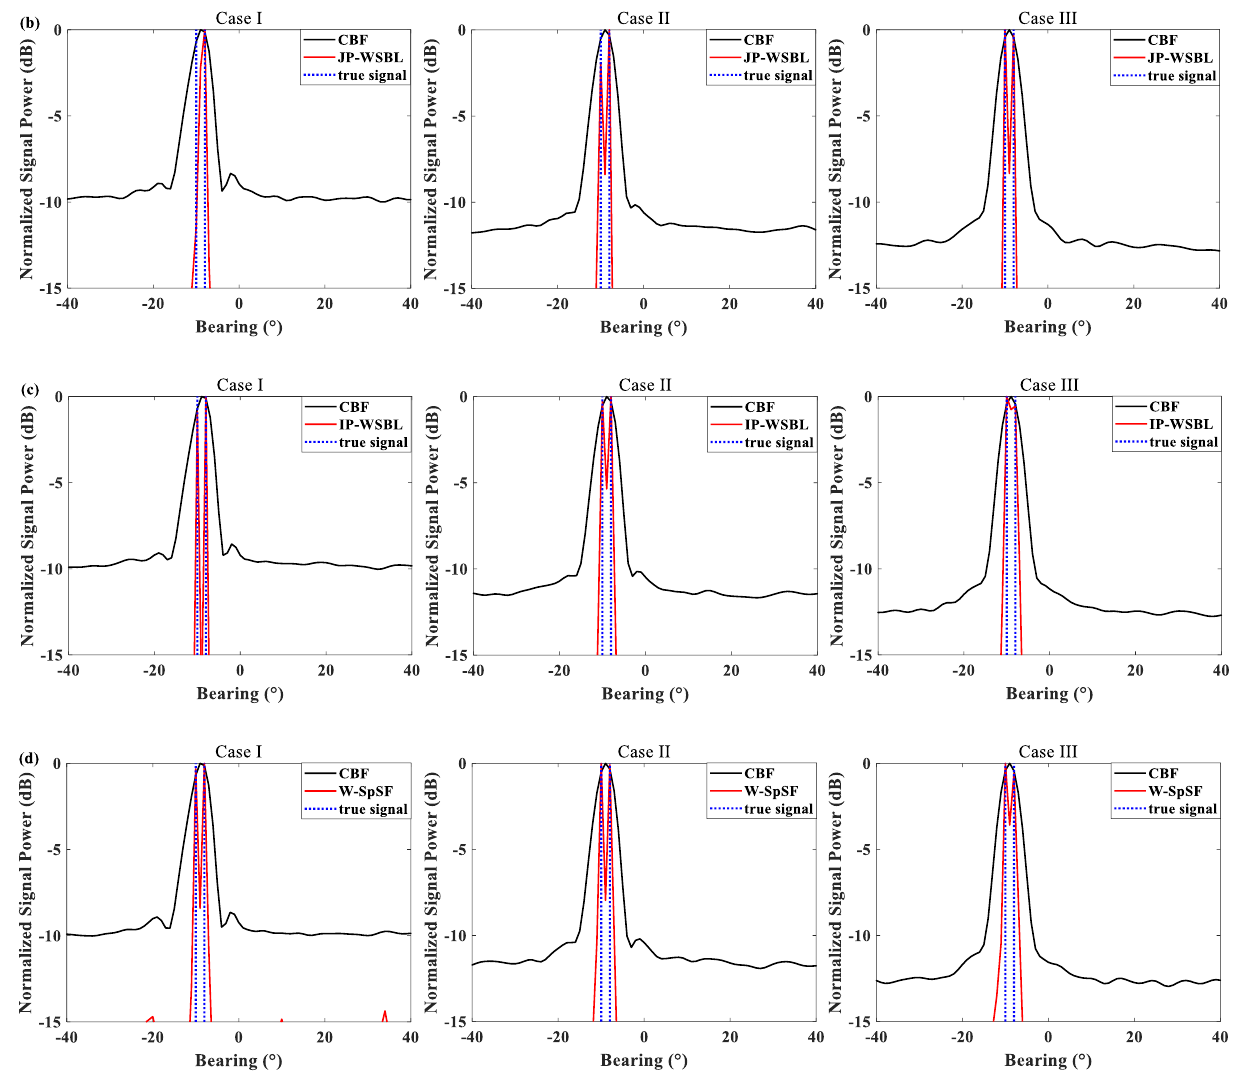
Figure 4. The comparison between CBF and ( a ) the proposed method, ( b ) JP-WSBL, ( c ) IP-WSBL and ( d ) W-SpSF under three different cases.